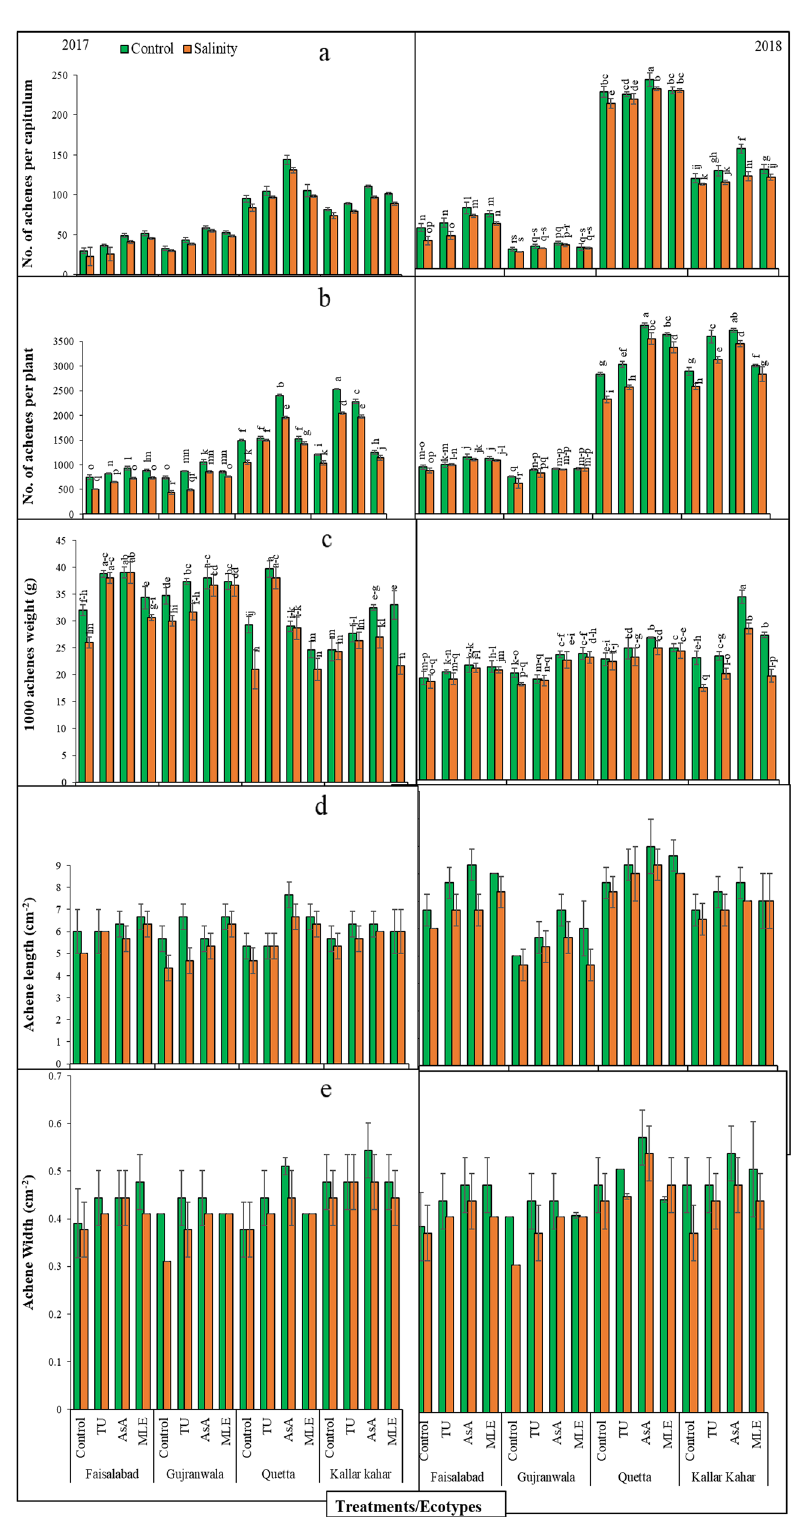
Figure 2. ( a ) No. of achene per capitulum, ( b ) no. of achene per plant, ( c ) 1000 achene weight ( d ) achene length, and ( e ) achene width of milk thistle under control and salinity stress conditions. The plants were soil supplemented with different plant growth promoters during 2017 and